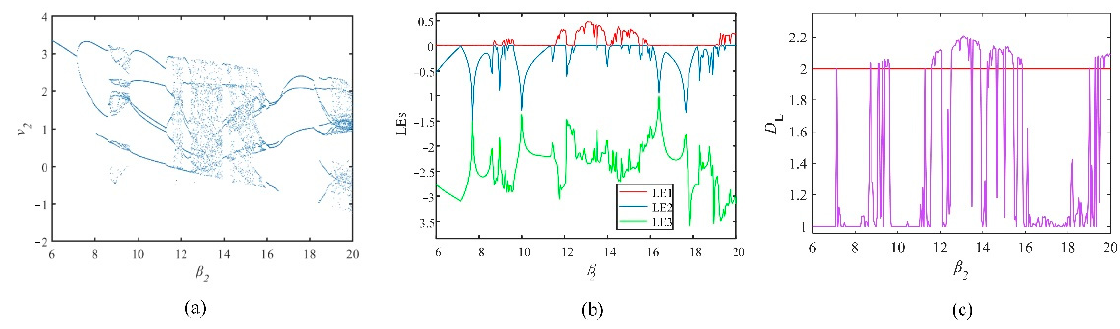
Figure 7. Synaptic weight β 2 ∈ (6, 20), q = 0.8, β 1 = 0.2. ( a ) Bifurcation diagram; ( b ) Lyapunov exponents spectrum; ( c ) Lyapunov dimension.